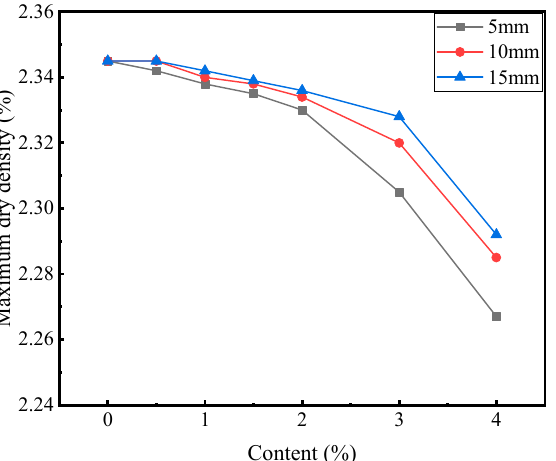
Figure 4. Relationship between the maximum dry density and fiber content.